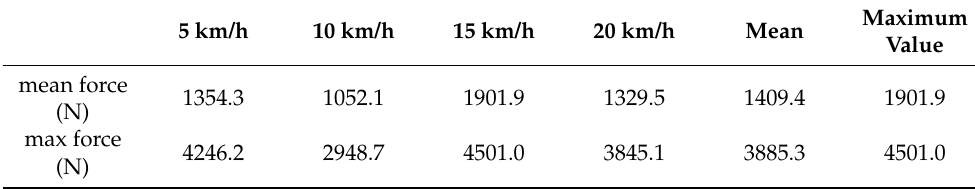
Table 6. Statistical characteristics of the 15 m span contact force curve.